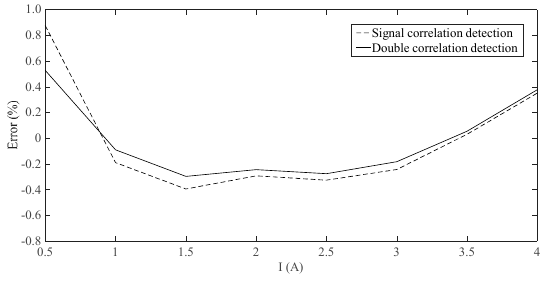
Figure 7. Error comparison.